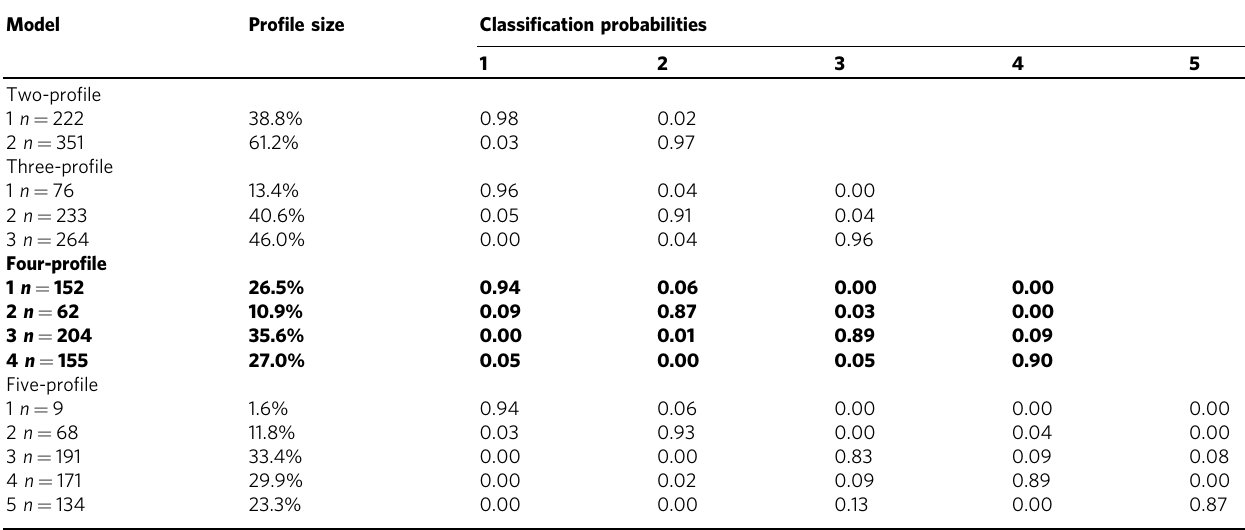
Table 5 Final cluster counts, pro fi le size, and classi fi cation probabilities for most likely latent pro fi le membership for the different models.